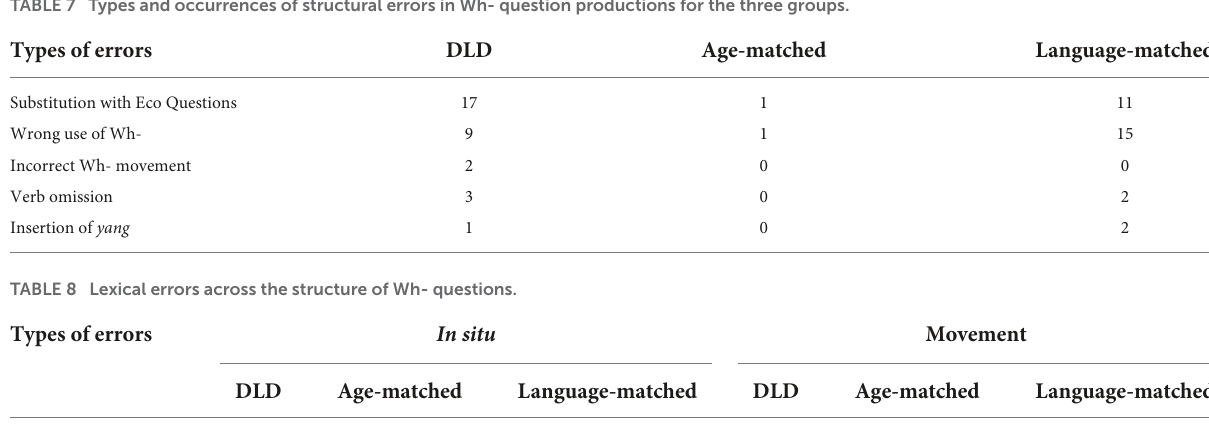
TABLE 7 Types and occurrences of structural errors in Wh- question productions for the three groups.